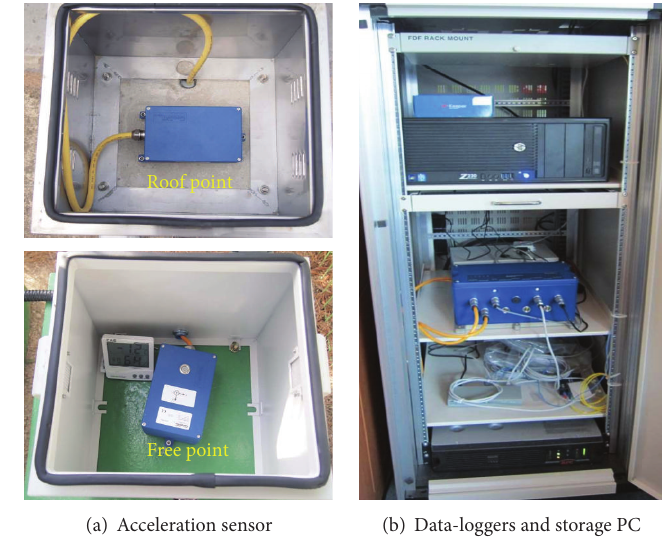
Figure 3: Experimental setting of acceleration sensors at measuring points and SHM